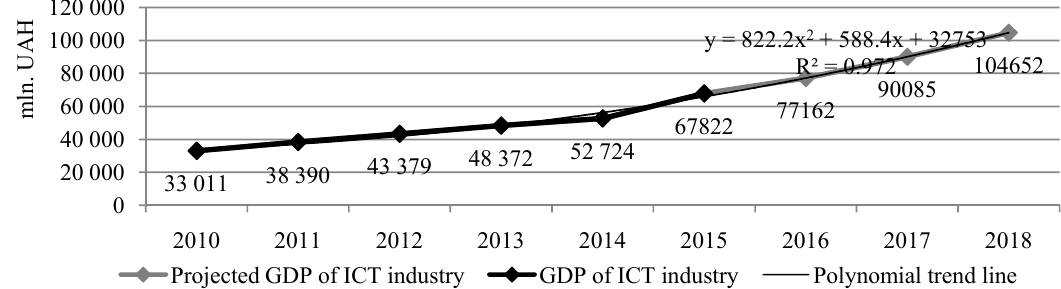
Fig. 4. Predictive value of IT market volume according to polynomial trend line in 2016-2018